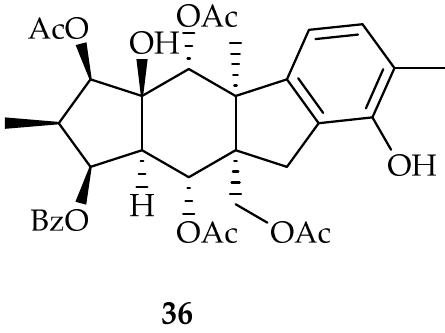
Figure 15. Structure of euphodeflexin O 36 [20].